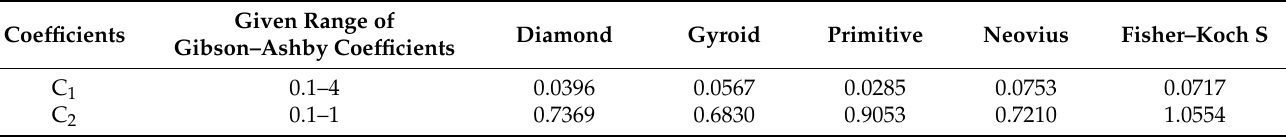
Table 3. Gibson–Ashby coefficient values for different TPMS